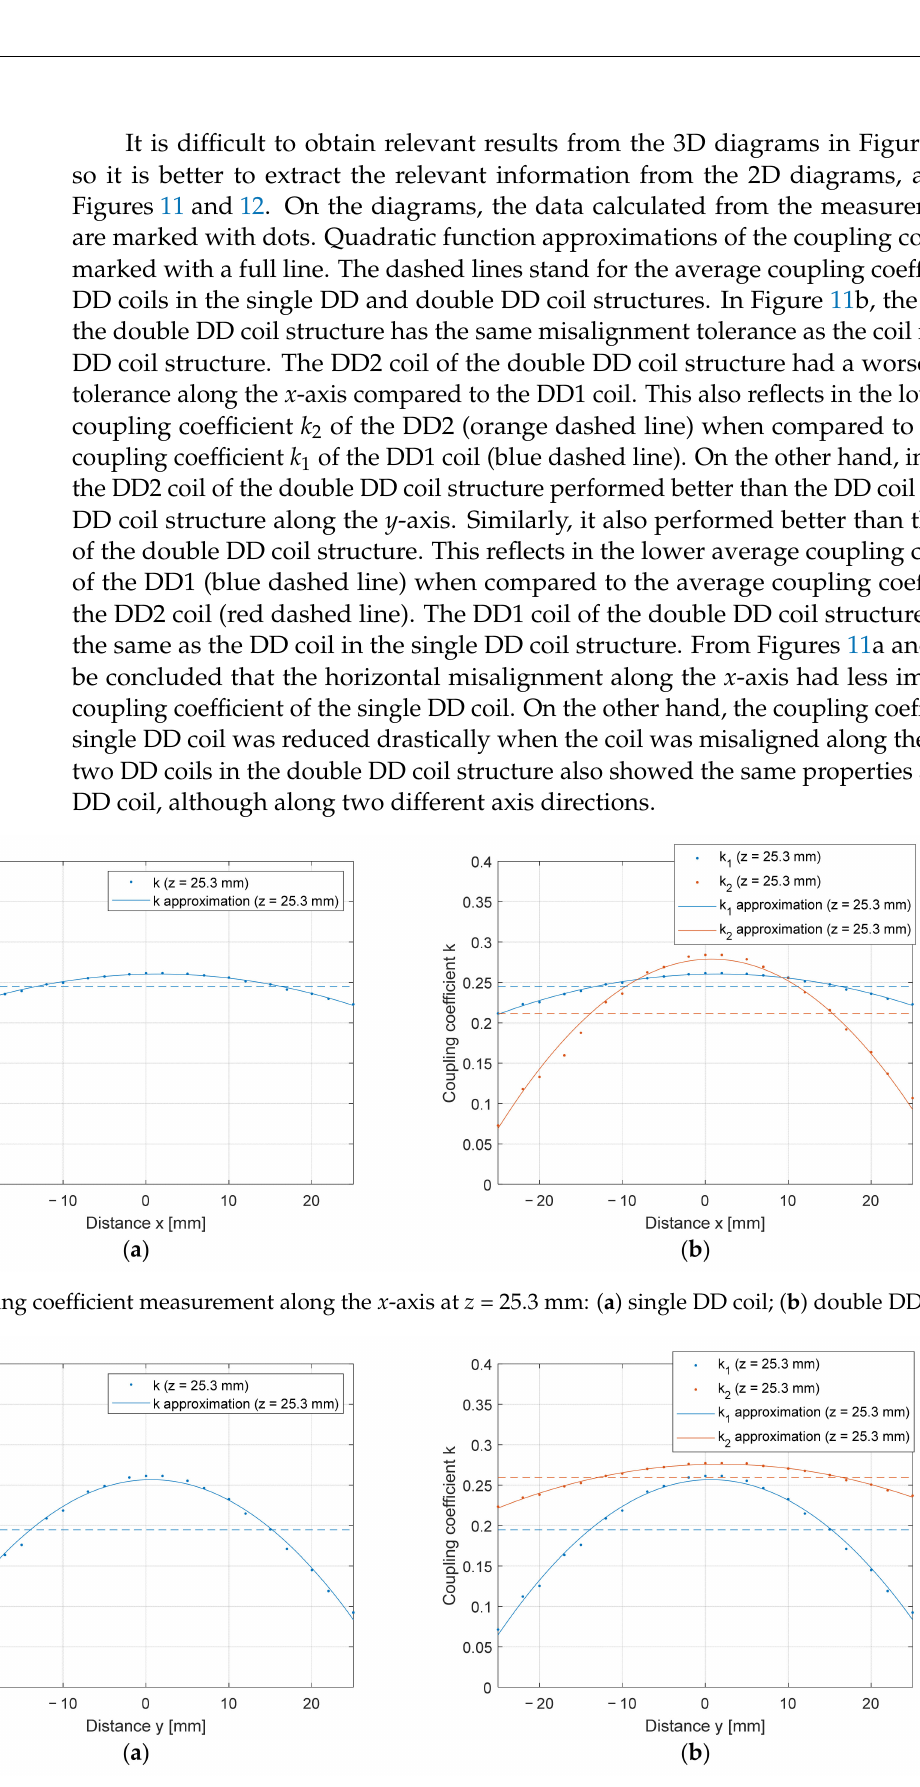
Figure 12. Coupling coefficient measurement along the y -axis at z = 25.3 mm: ( a ) single DD coil; ( b ) double DD